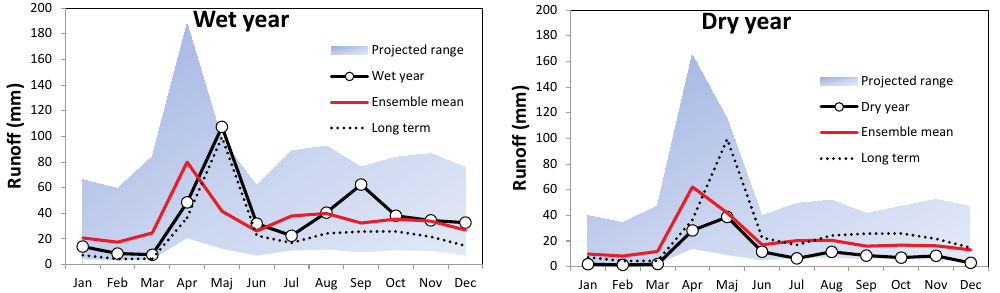
Figure 8. Example of the range of runoff projection using wet year parameterization that closely depicts the future vs. projected range based on dry year parameterization. The projected range was simulated to constrain uncertainty in extreme wet and dry conditions in the future using the behavioural parameter sets (top 100 iterations from MCMC) for each of the 15 RCM scenarios (100 parameters by 15 RCMs = 1500 runs each for dry and wet years). The ensemble mean represents the mean of the 1500 realizations, while long term depicts the mean of the long-term